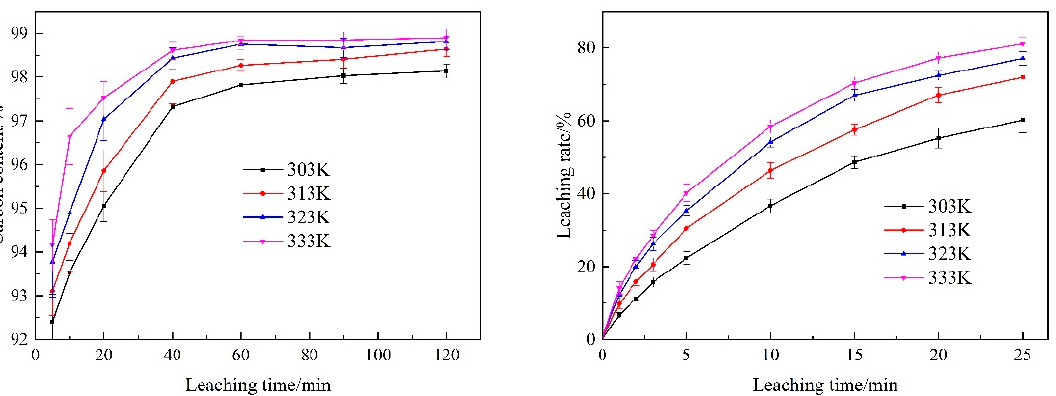
Figure 6. Effect of temperature on carbon content ( left ) and Al leching rate ( right ) (initial HCl concentration 4 mol/L, particle size D(50) = 67.49 µ m, NaF 0.3 mol/L).